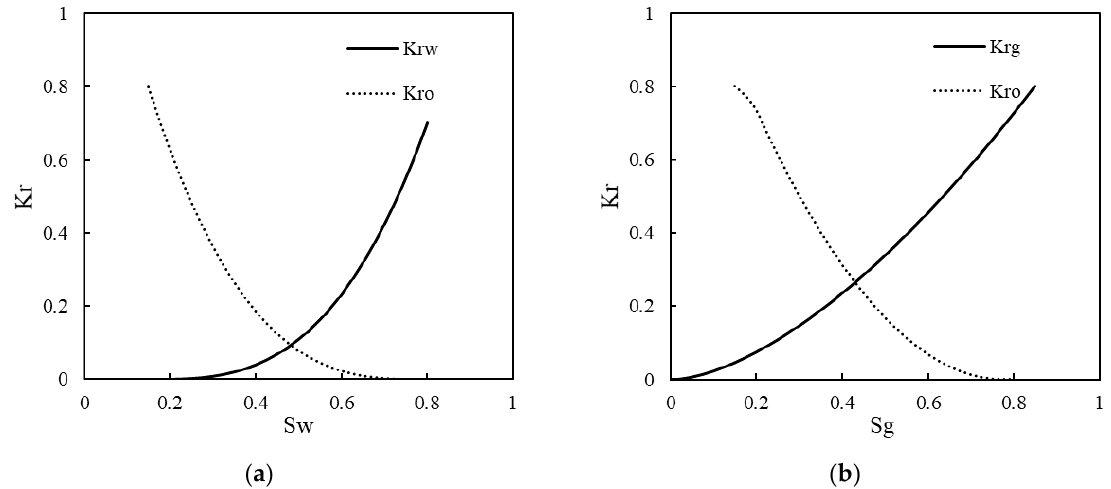
Figure 12. Oil-water relative permeability ( a ) and oil-gas relative permeability ( b ) in shale matrix.